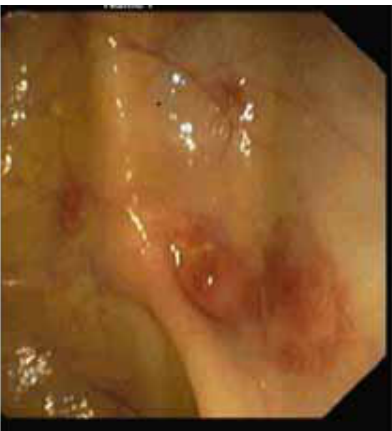
Figure 1: Colonic mucosa showing haemorrhagic